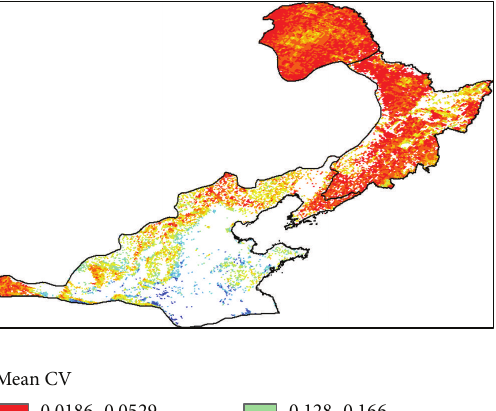
Figure 5: Boxplot of the coefficient of variation (CV) for five satellite-derived SOS measures in pixels with broadleaf forest and ground FLD time series at 12 sites. The bottom and top of the box are the 25th and 75th percentile, and the band near the middle of the box is the median. The 𝑥 designates the mean